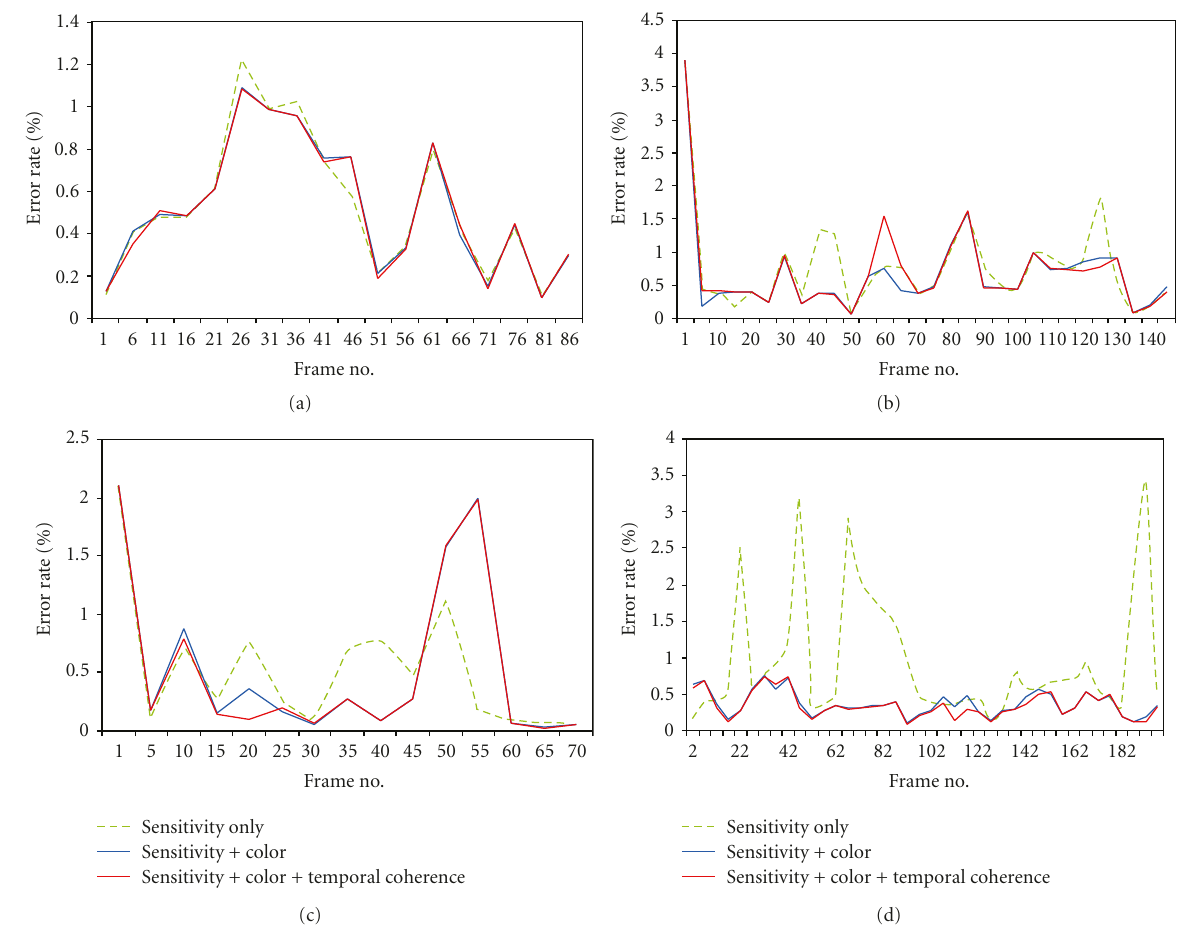
Figure 10: The error rates of the proposed algorithm I on the (a) “Dolls,” (b) “Throwing Doll,” (c) “Moving Object and Background,” and (d) “Woman in Red” sequences. Each curve corresponds to a di ff erent combination of features. In every curve, the smoothness term is included in the energy minimization.